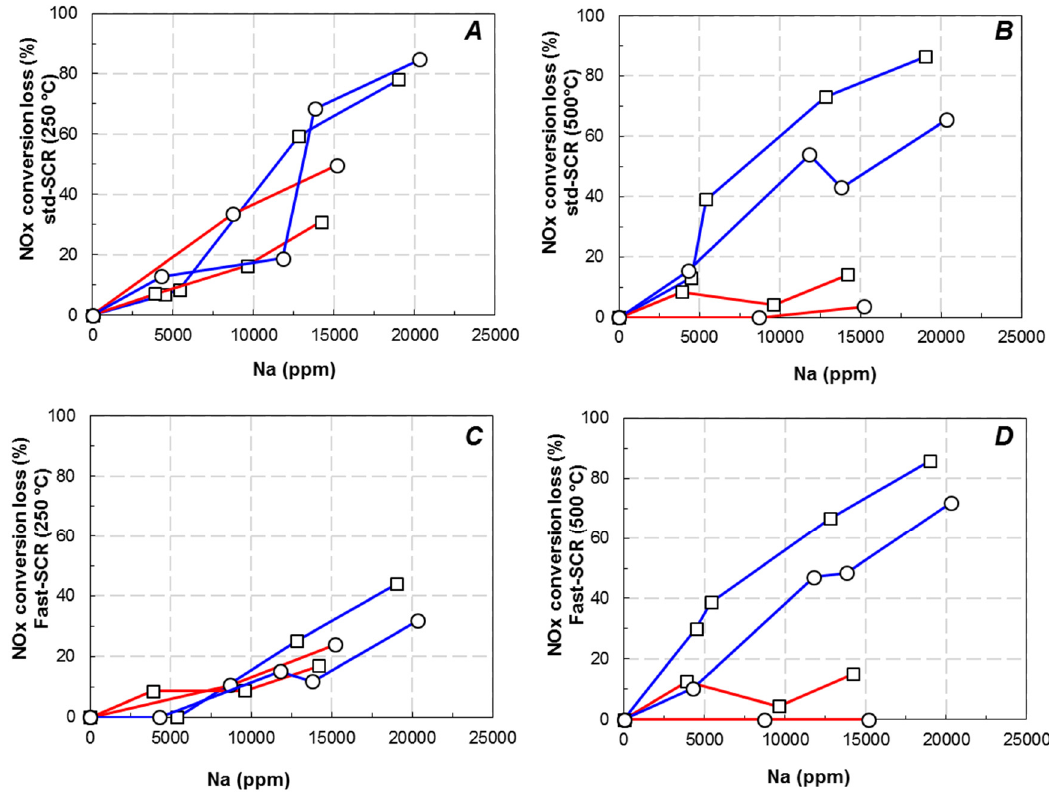
Figure 2. NO x conversion loss in function of the sodium loading on Cu/FER zeolites in standard ( A , B ) and Fast ‐ SCR ( C , D ) at 250 °C ( A , C ) and 500 °C ( B , D ). : Cu 2.8 /FER; : Cu 6.1 /FER. (Na impregnation in water: blue line; sodium impregnation in ethanol: red line).